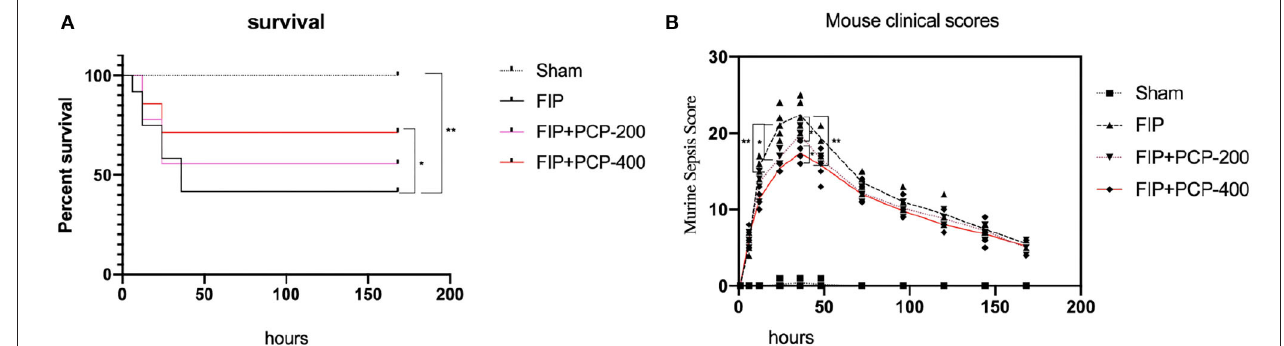
FIGURE 1 | Poria cocos polysaccharide (PCP) pretreatment improved the 7-day survival and Murine Sepsis Score (MSS) of septic mice. (A) The survival of mice in the normal group was in good condition and the survival rate of mice decreased linearly after fecal injection. While the mice received PCP, the survival rate increased significantly, but the survival rate had no significant difference between receiving PCP of 200 and 400 mg/kg/day. (B) The MSS of experiment mice in each group. The MSS of mice increased significantly at 6h after fecal injection, the upraise lasts for 24h, and a peaked at 36h after treatment. The MSS of PCP-treated mice increased less. Meanwhile, there was no difference in the MSS between PCP 200 and PCP 400 mg-treated mice. * P < 0.05; ** P < 0.01, FIP + PCP-200 = FIP with PCP 200 mg/kg/day; FIP + PCP-400 = FIP with PCP 400 mg/kg/day. n = 12.